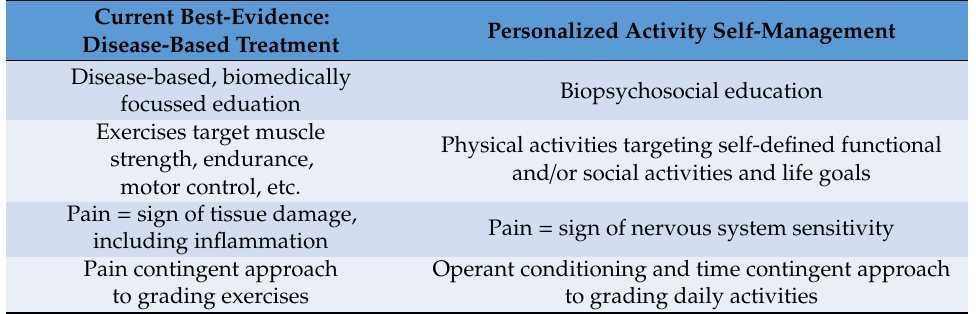
Proposed paradigm shift from disease-based treatment to personalized activity self-management for